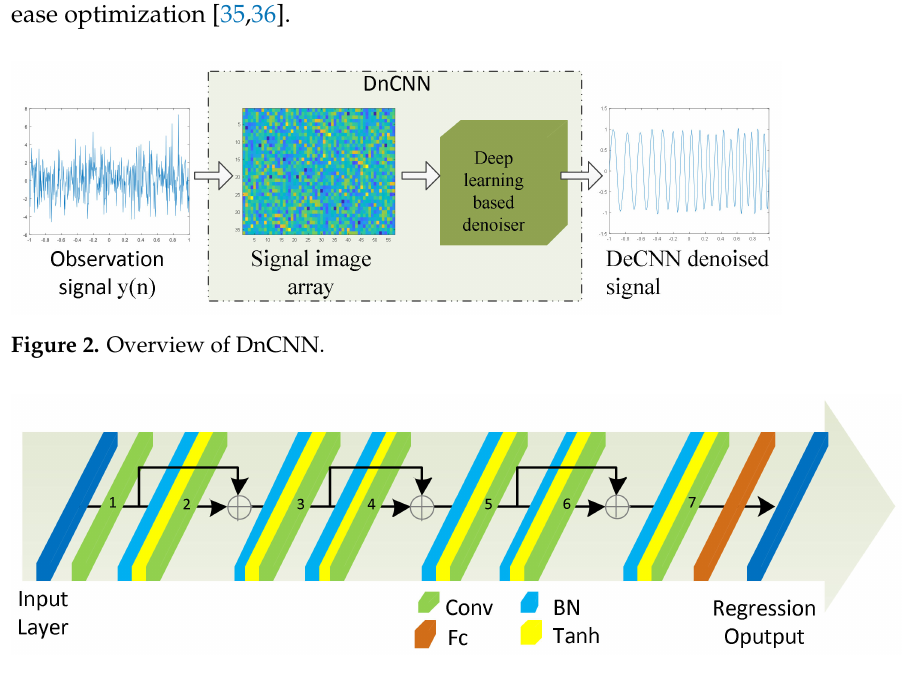
Figure 1. Schematic diagram of the proposed estimator, y ( n ) is an observation signal, y (cid:48) ( n ) is the output of Denoising Convolutional Neural Network (DnCNN), estimator.